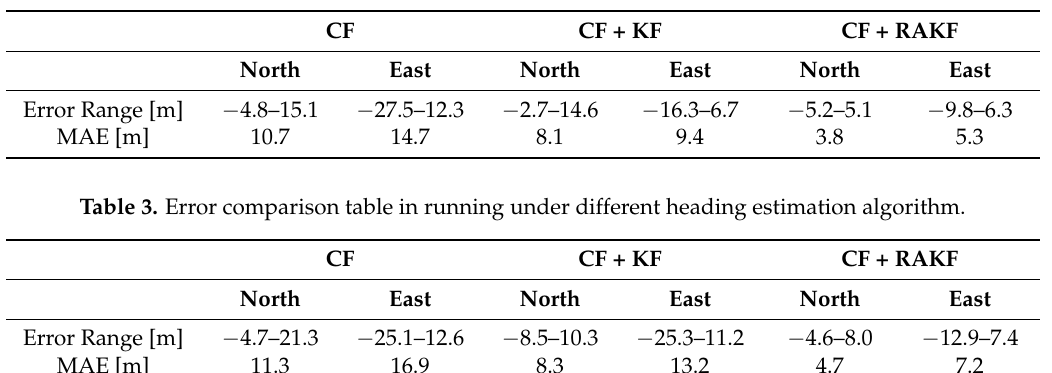
Figure 13. Trajectory analysis in running under different heading estimation algorithms. ( a ) North error comparison; ( b ) East error comparison.